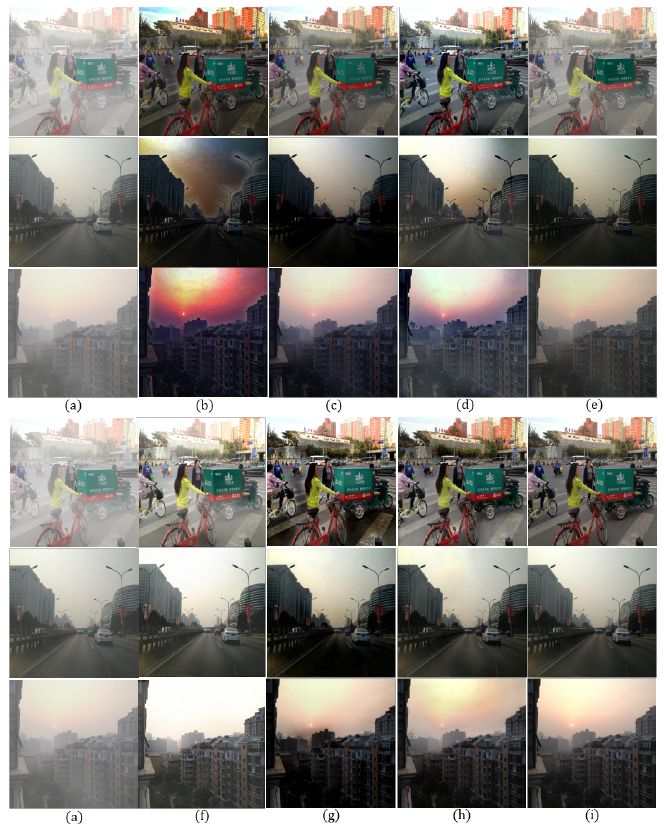
Figure 5. Comparison of dehazing results using synthetic outdoor hazy images [35] for qualitative evaluation: ( a ) hazy input image, ( b ) DCP [9], ( c ) CAP [10], ( d ) RRO [4], ( e ) AOD [37], ( f ) DCPDN [17], ( g ) GFN [18], ( h ) the proposed method, and ( i ) clean